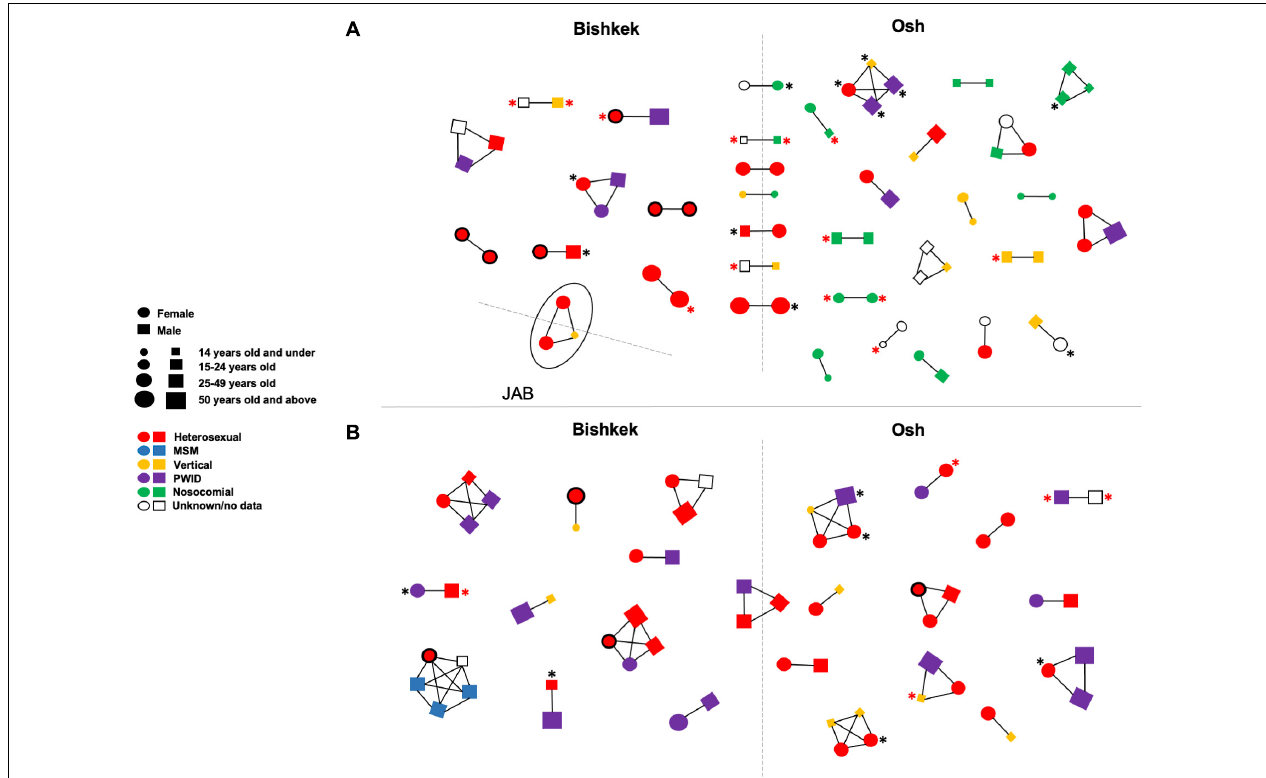
FIGURE 2 | Transmission clusters of study HIV-1 pol sequences ofCRF02_AG/CRF63_02A (A) and sub-subtype A6 (B) . Clusters were detected in IQ-TREE at maximum 0.045 genetic distances and 90 branch support thresholds. Each figure (circle/square) corresponds to a node on the phylogenetic tree; figure shape, size, and color correspond to an individual’s gender, age, and HIV-1 transmission mode according to the left center footnote. The line drawn between figures indicates that HIV-1 sequences from the respective individuals in phylogenetic tree fell within the clustering thresholds. The black asterisk indicates the HIV-1 drug resistance; the red asterisk indicates the HIV-1 drug resistance to at least two ARV drug classes. Circles with the bold black border correspond to the pregnant women. The solid oval corresponds to a cluster of three individuals infected by CRF63_02A. The dashed lines divide figures corresponding to individuals from the different study regions. JAB, Jalal-Abad and Batken provinces; MSM, men who have sex with men; PWID, persons who inject